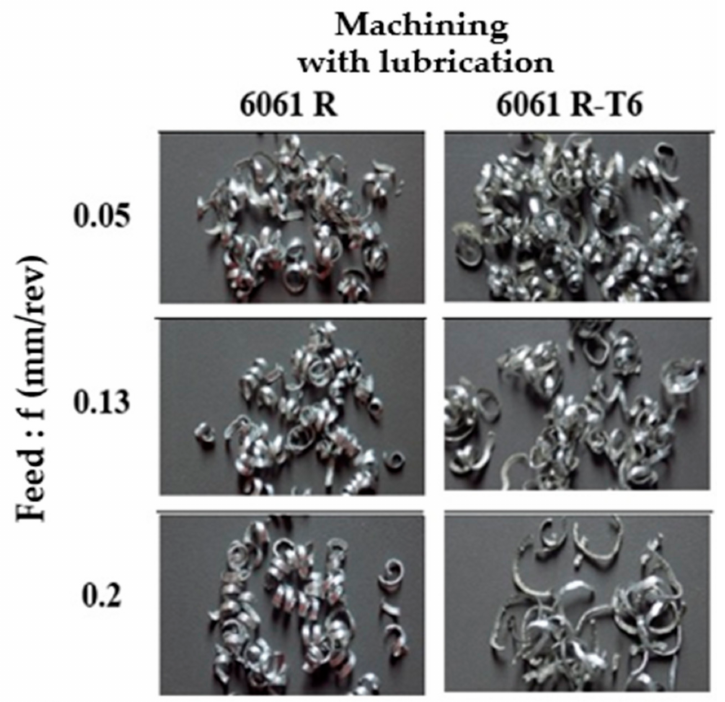
Figure 11. Morphology of chips of recycled alloys 6061 R and 6061 R-T6 machining with